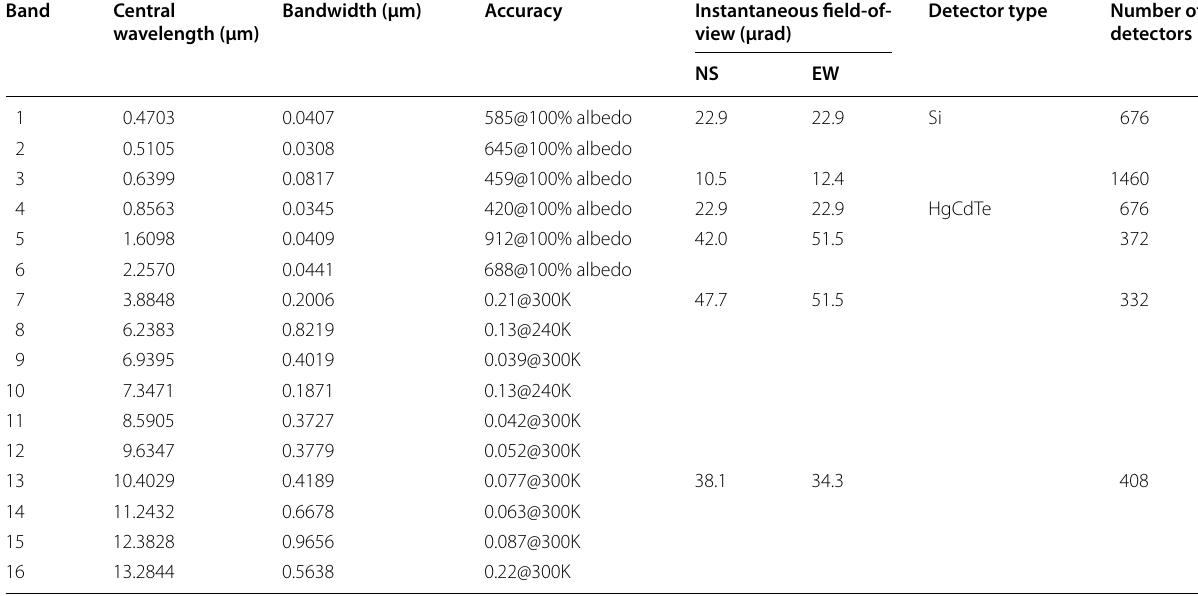
The accuracy values in bands 1–6 and 7–16 are the signal-to-noise ratio and noise-equivalent temperature, respectively. The instantaneous field-of-view of each detector differs between the north–south (NS) and east–west (EW) directions on the Moon